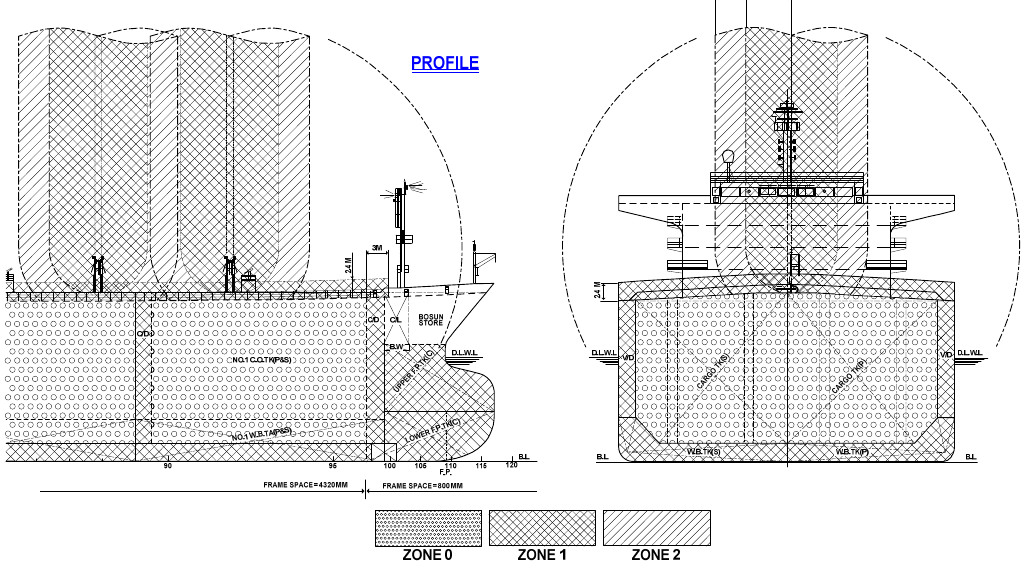
Figure 3. Dangerous zone plan in gas carrier according to IEC standard 60092-502.